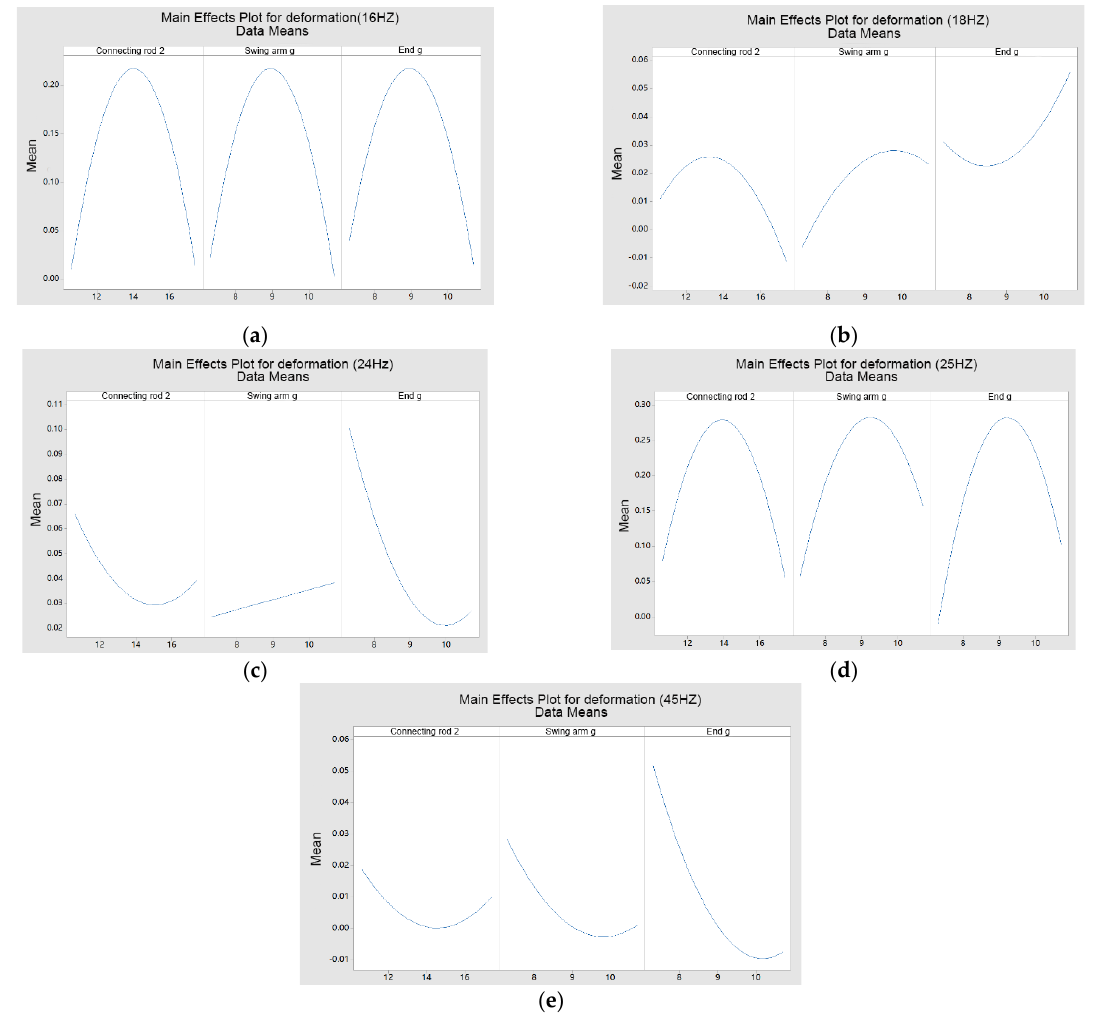
Figure 15. Main effect diagrams for the maximum amplitude displacement at the end of welding robot: ( a ) 16 Hz;( b ) 18 Hz; ( c ) 24 Hz; ( d ) 25 Hz; ( e ) 45 Hz.